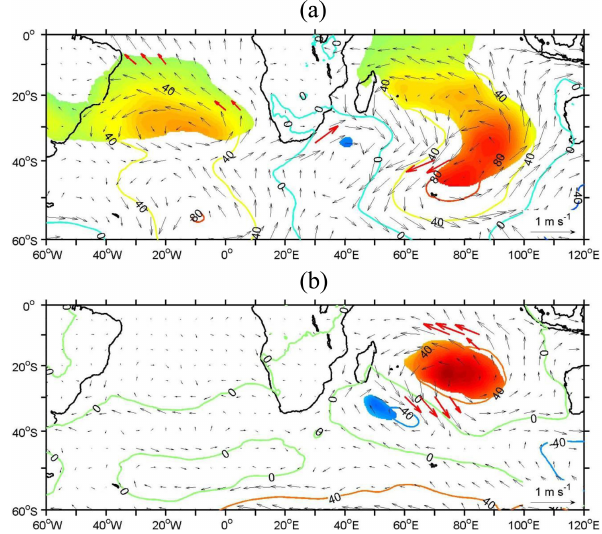
Figure 8. Regression maps of MSLP (in Pa) and the 10m wind field (vector) onto the summertime SIOD index over the periods of (a) 1979–1999 and (b) 2000–2020. Shaded regions and red vectors indicate that the confidence level is above